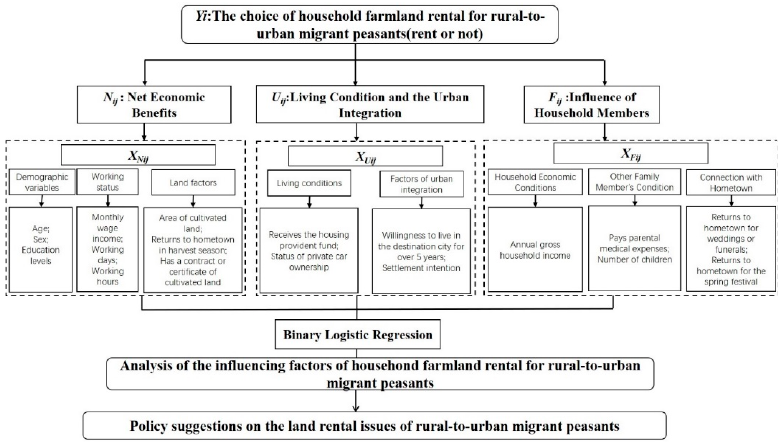
Figure 1. Analysis Framework.